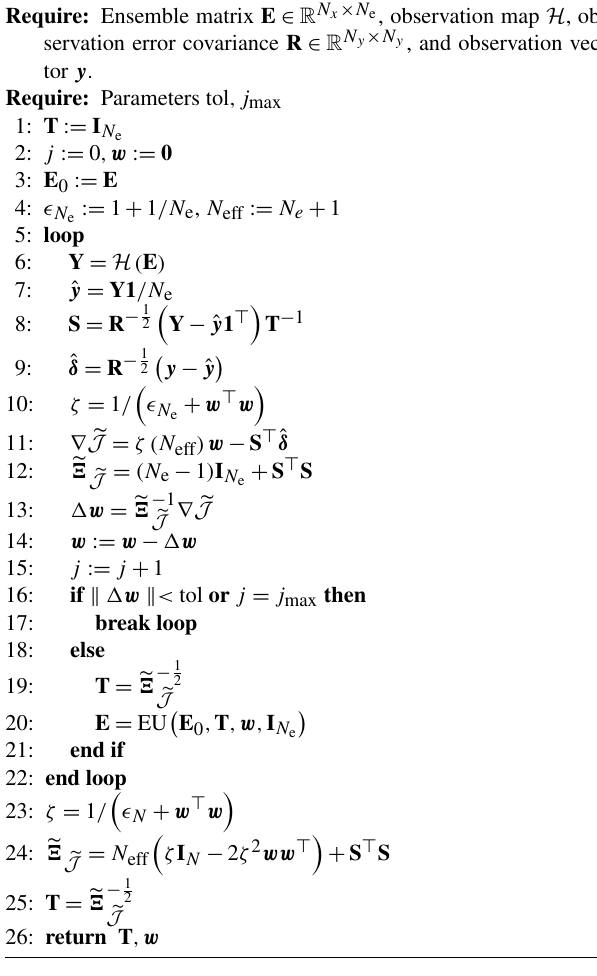
Algorithm A8 SIEnKS in the SDA version.